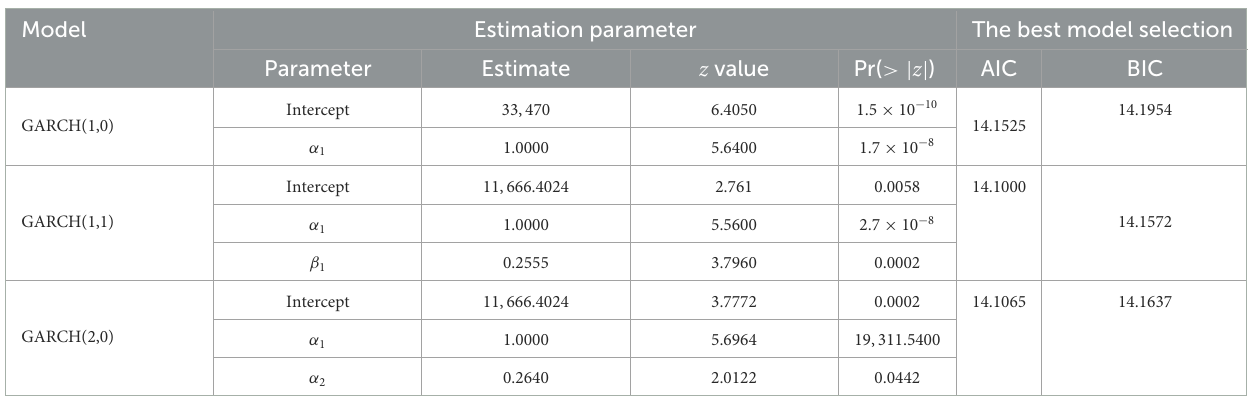
TABLE 6 Estimation of significant parameters of the GARCH model with their AIC or BIC value. Model Estimation parameter The best model